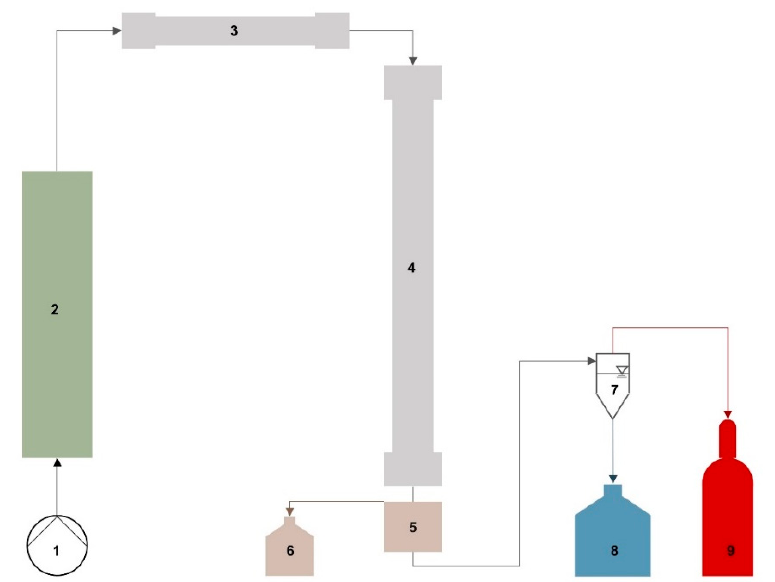
Figure 1. Schematic flow diagram of SCWG reactor and peripheral components. ( 1 ): pump, ( 2 ): biomass feed cylinder, ( 3 ): preheating section, ( 4 ): reactor, ( 5 ): salt separation, ( 6 ): salt brine, ( 7 ): gas-liquid phase separation, ( 8 ): reactor effluent, ( 9 ): product gas.